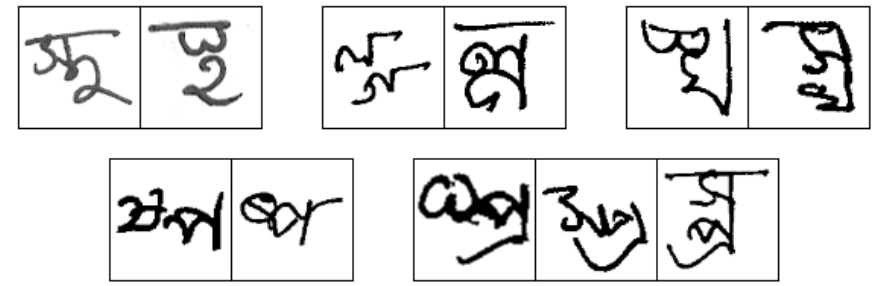
Figure 12. Examples for characters with multiple writing